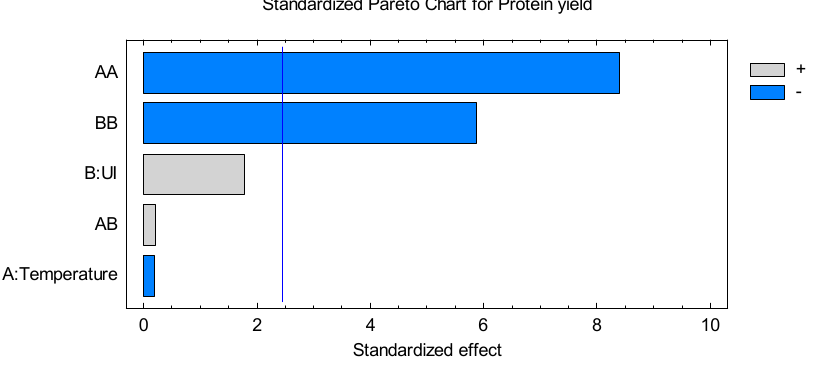
Figure 2. Standardized Pareto Chart for protein yield.